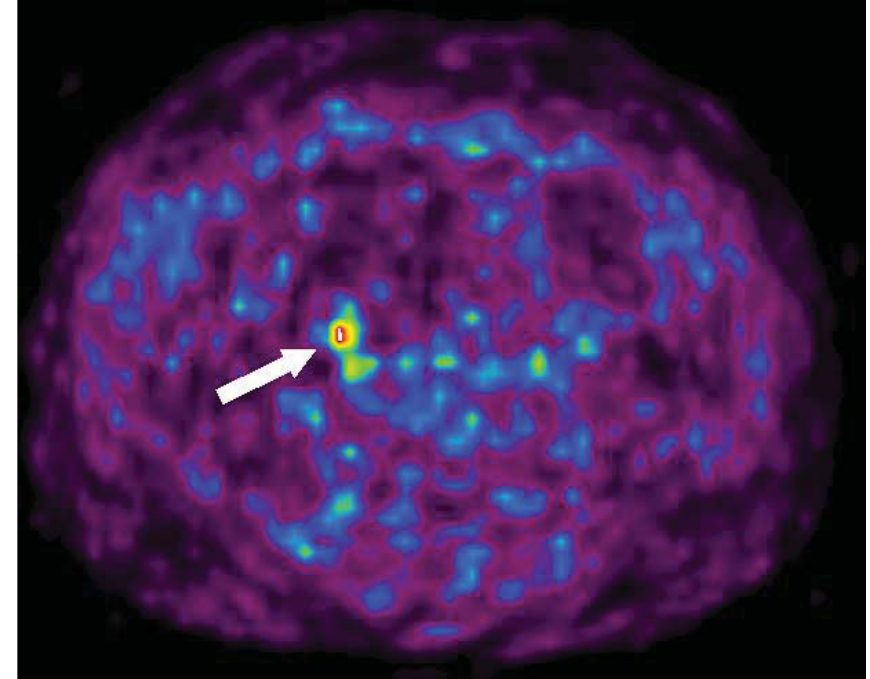
Figure 1. Transaxial 11 C-5-HTP PET image of a patient with small intestinal NET (patient 16). A suspicious metastatic lymph node metastasis is seen (arrow). It was later confirmed at